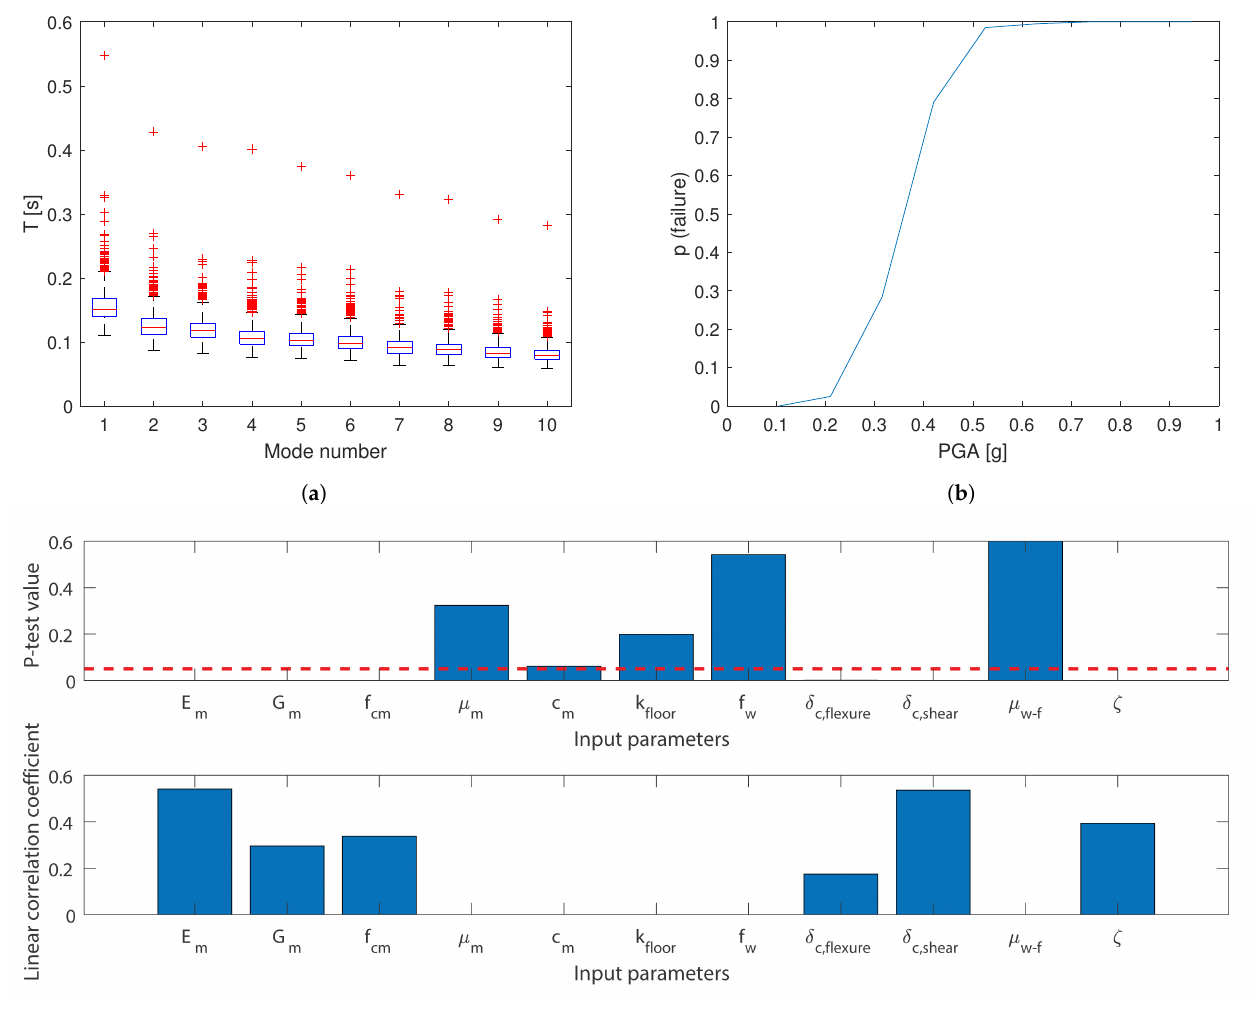
Figure 10. Holsteiner Hof model: ( a ) Distribution of modal periods. ( b ) Fragility curve. ( c ) Correlations between the PGA at failure and input